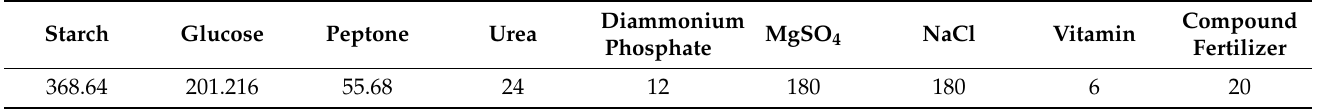
Table 2. High concentration organic water matching ratio (unit: g/20